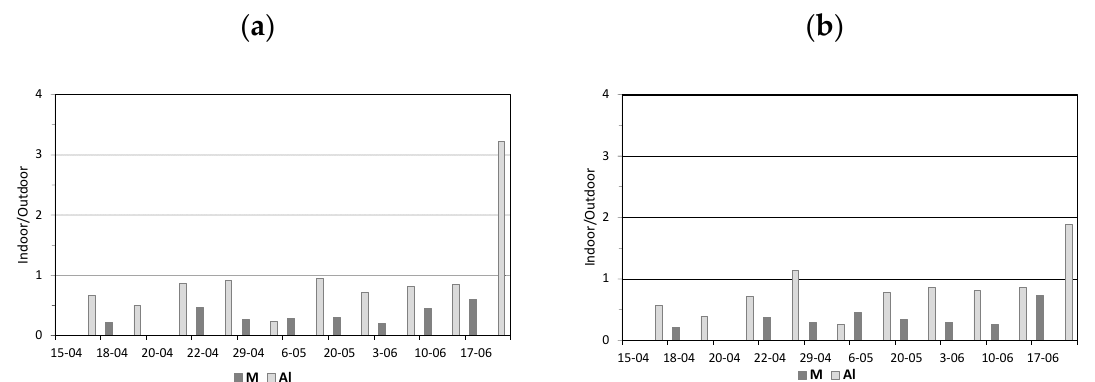
Figure 2. The indoor/outdoor ratio of the number of suspended particles in the morning (M) and after lessons (Al), ( a ) in classroom 04, ( b ) in classroom 105.